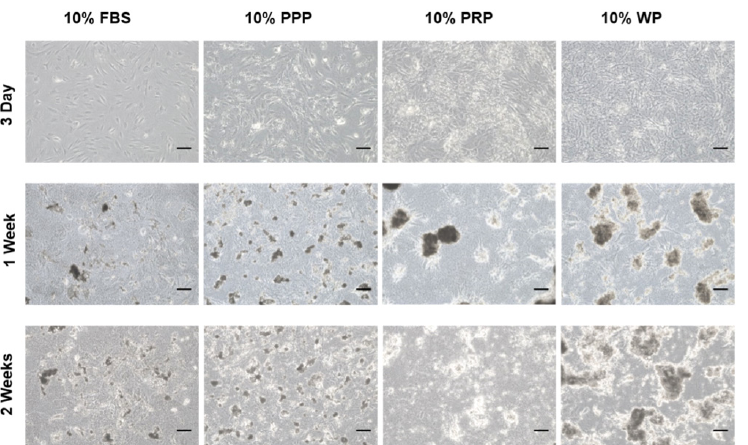
Figure 3. ECM mineralization of the cultured rSVFs at passage 1. Optical microscopic images on day 3, 1 week, and 2 weeks showed the most mineralization in the rat stromal vascular fraction cells treated with 10% ( v / v ) WP. PPP: platelet-poor plasma, PRP: platelet-rich plasma, WP: whole plasma, scale bar: 100 µm, magnification: